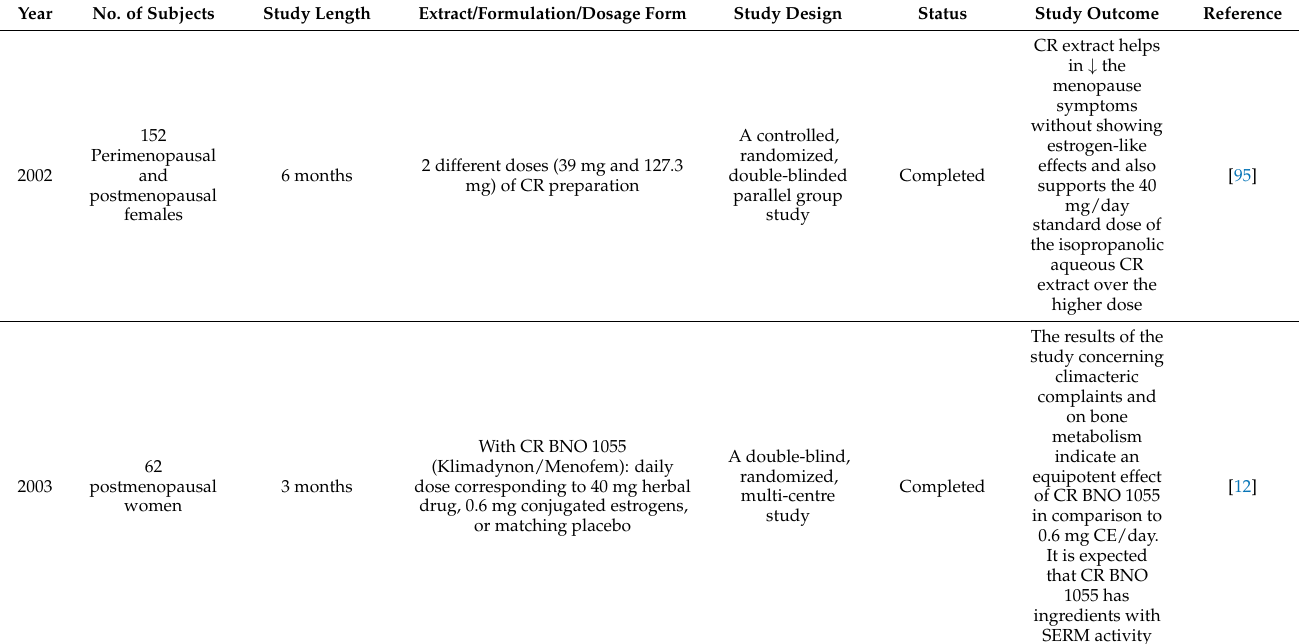
Table 6. Clinical trials of CR relating to women’s